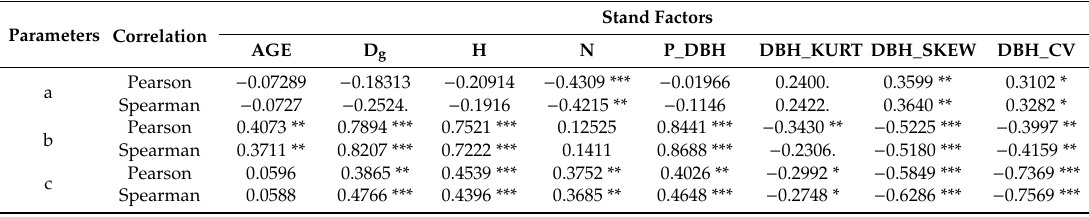
Table 5. Pearson correlation coe ffi cient and Spearman correlation coe ffi cient between parameters and stand